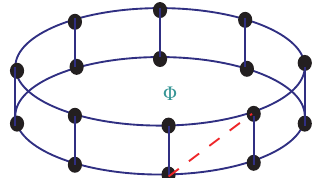
Figure 9 Schematic view of a 1D mesoscopic cylinder pene- trated by a magnetic fl ux φ . The red dashed line corresponds to the SNH integral, and the fi lled black circles represent the posi- tions of the atomic sites. A persistent current I is established in the